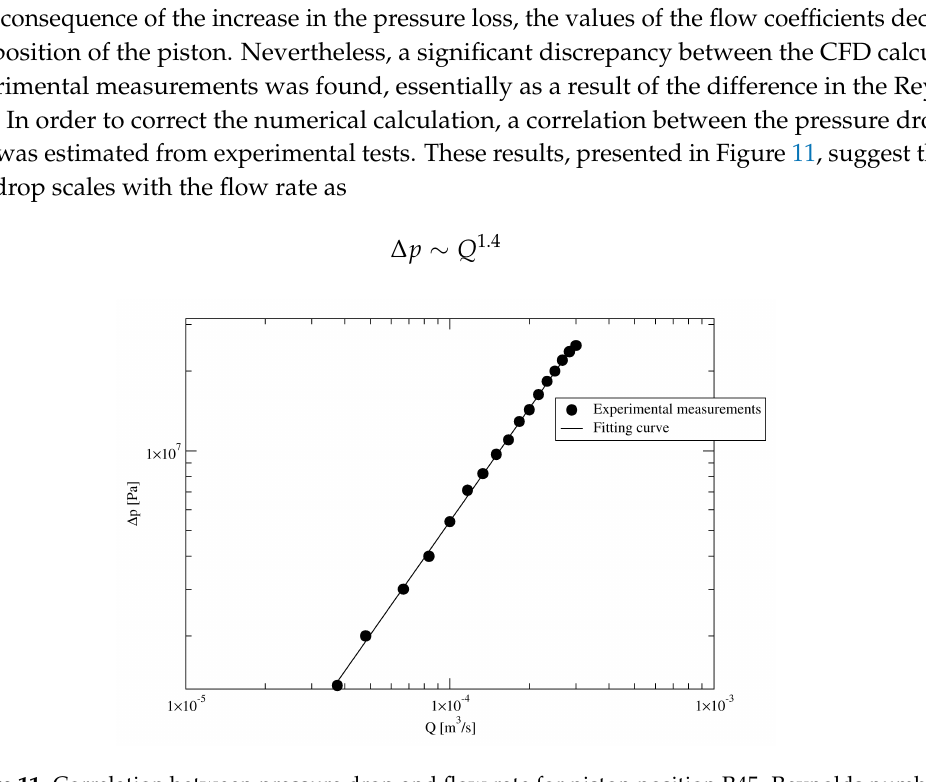
Figure 11. Correlation between pressure drop and flow rate for piston position R45. Reynolds number ranges from 12 to